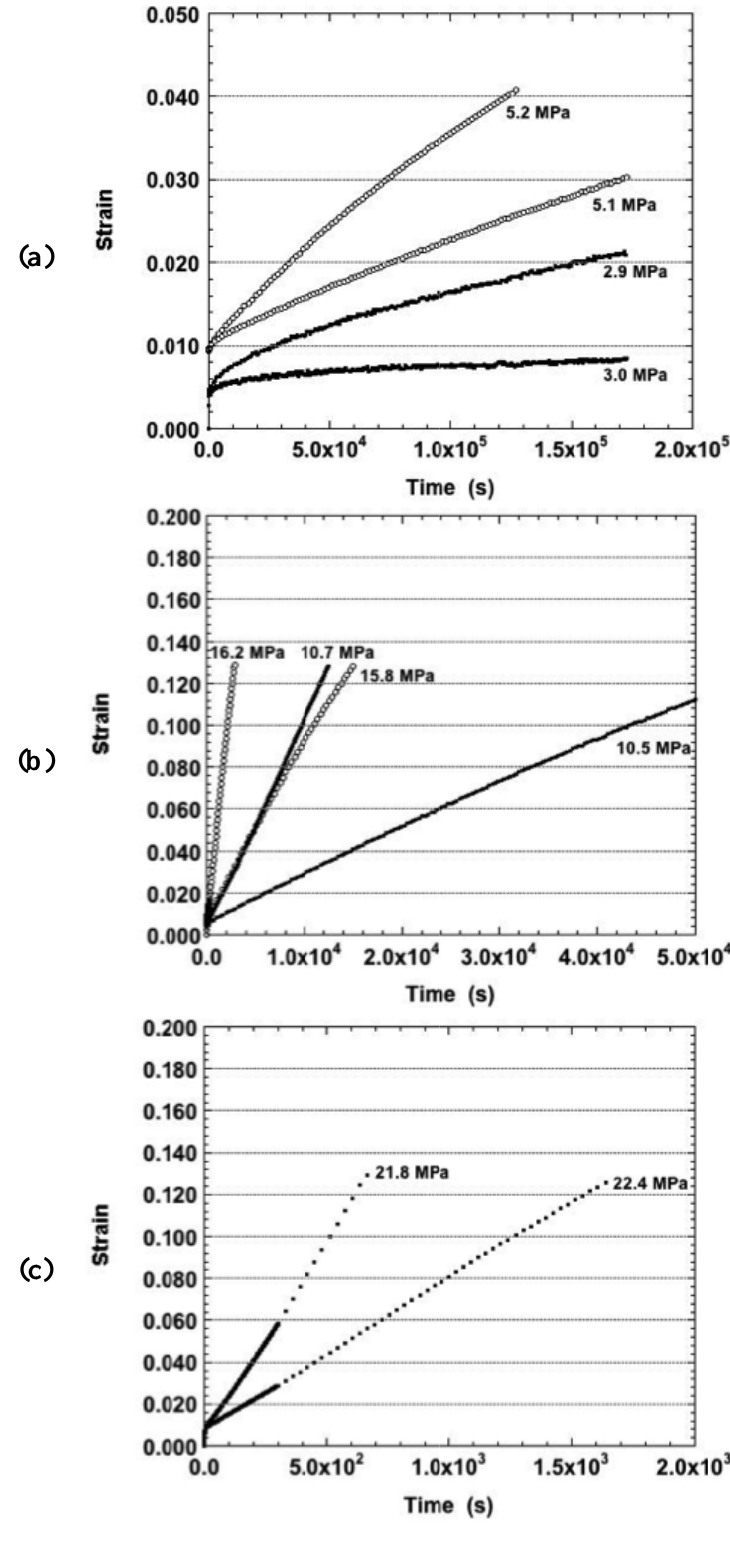
012 , 5 Figure e 4. The str and at t a temper ( b ) 12 .0 MPa and